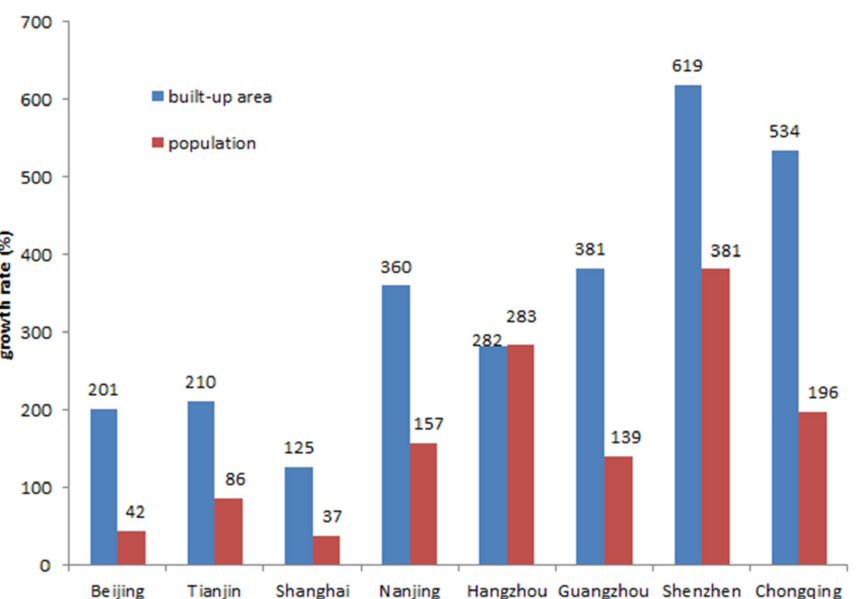
Figure 1. Growth rate of built-up areas and population during 1998–2019 for some large cities in